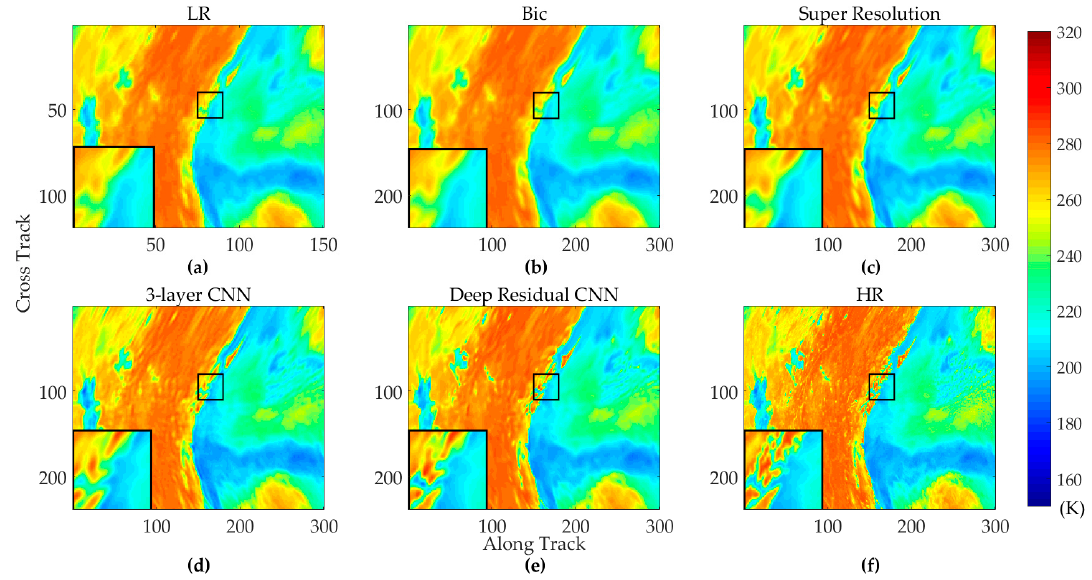
Figure 7. Experiment results of the scene 2 (in training set). ( a ) The simulated antenna temperature image LR I ; ( b ) The bicubic interpolation result; ( c ) The super resolution result; ( d ) The 3-layer CNN result; ( e ) The deep residual CNN result; ( f ) The simulated brightness temperature image HR I .